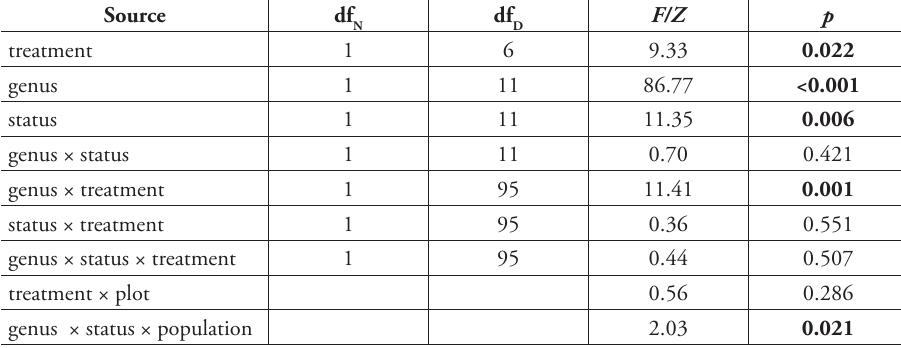
Table 1. Results of the mixed model analysis of the among-species approach testing for pre-adaptation.